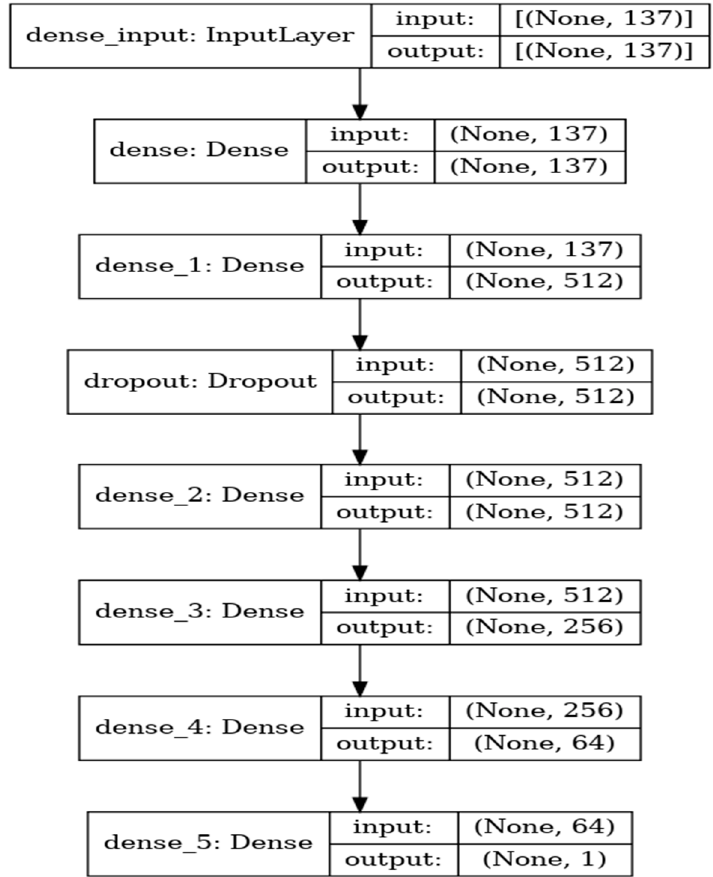
Figure 2. The schematic plot of the deep learning (DL) model adopted in this work, which consists of one input layer, five hidden layers and one output layer.